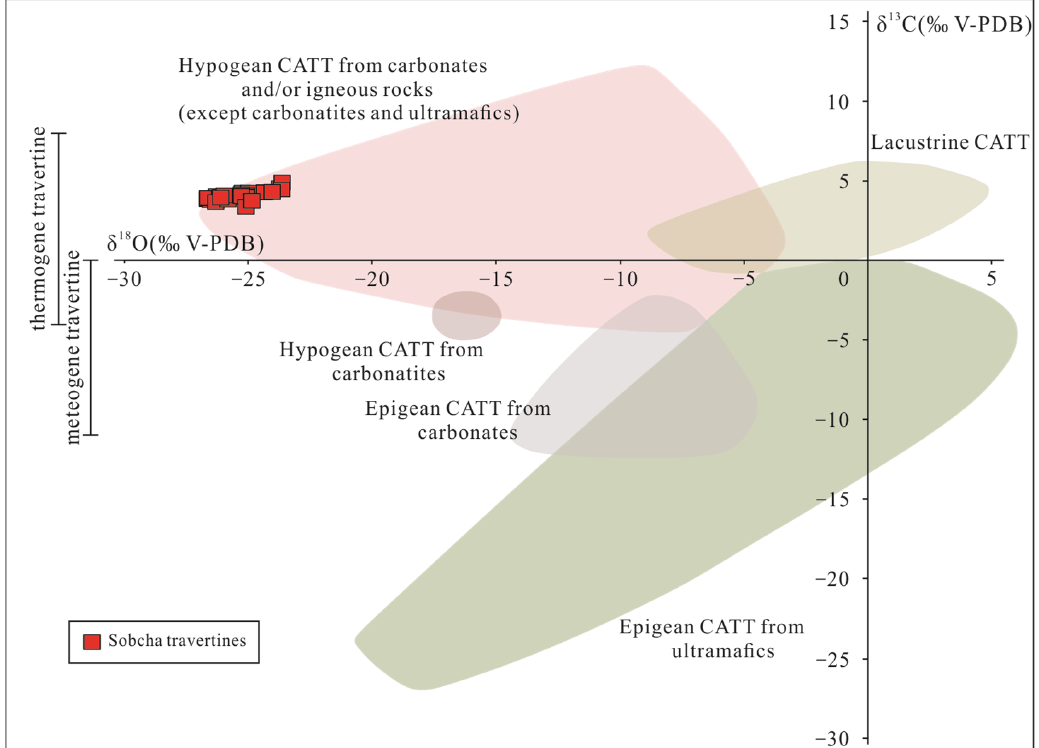
Figure 6. δ 13 C and δ 18 O composition for the Sobcha travertines . δ 13 C ranges for thermogene and meteogene travertines were from Pentecost and Viles [64]. δ 13 C and δ 18 O ranges of different CATT